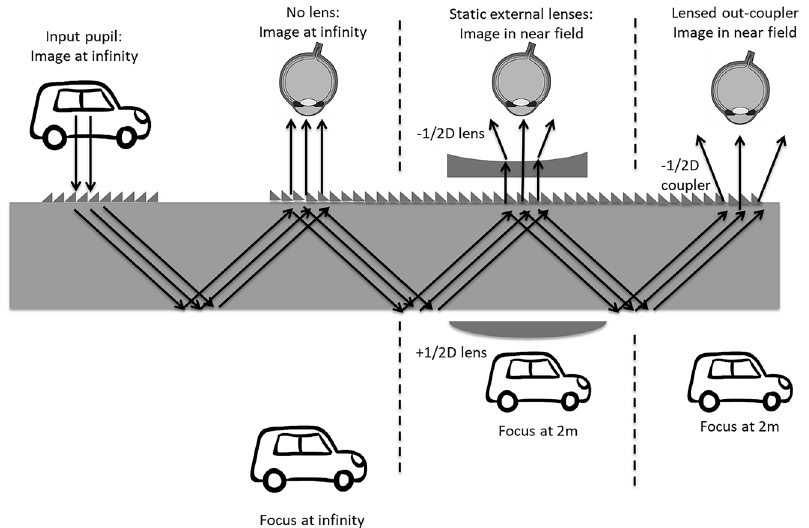
Figure 26: Two out-coupler architectures positioning the virtual image in the near field over all exit